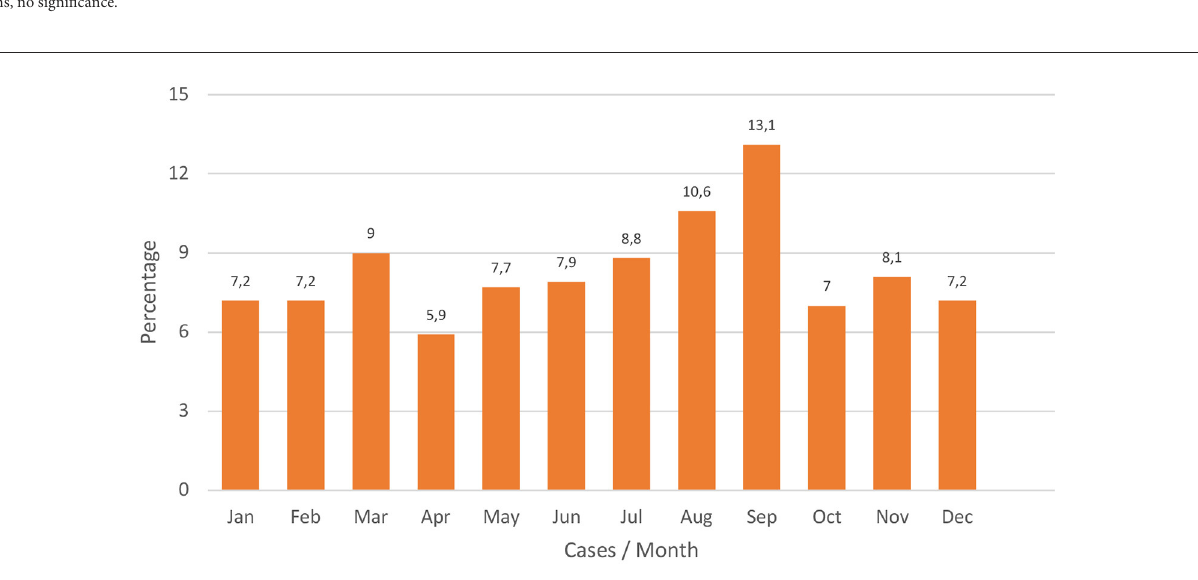
FIGURE2 Distribution of cases by months (in percentage).